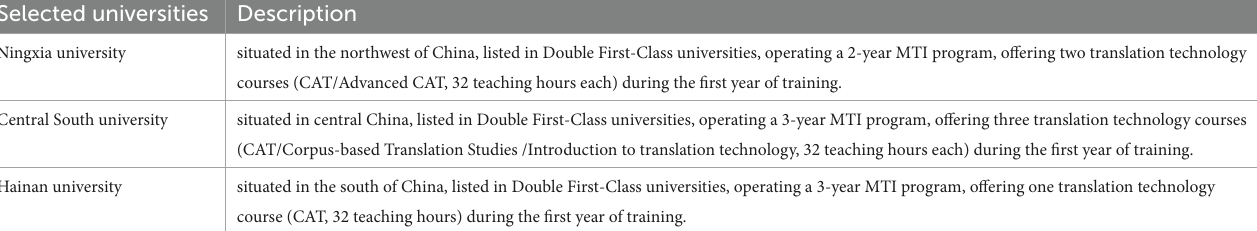
TABLE 1 Descriptive profiles of the selected universities.